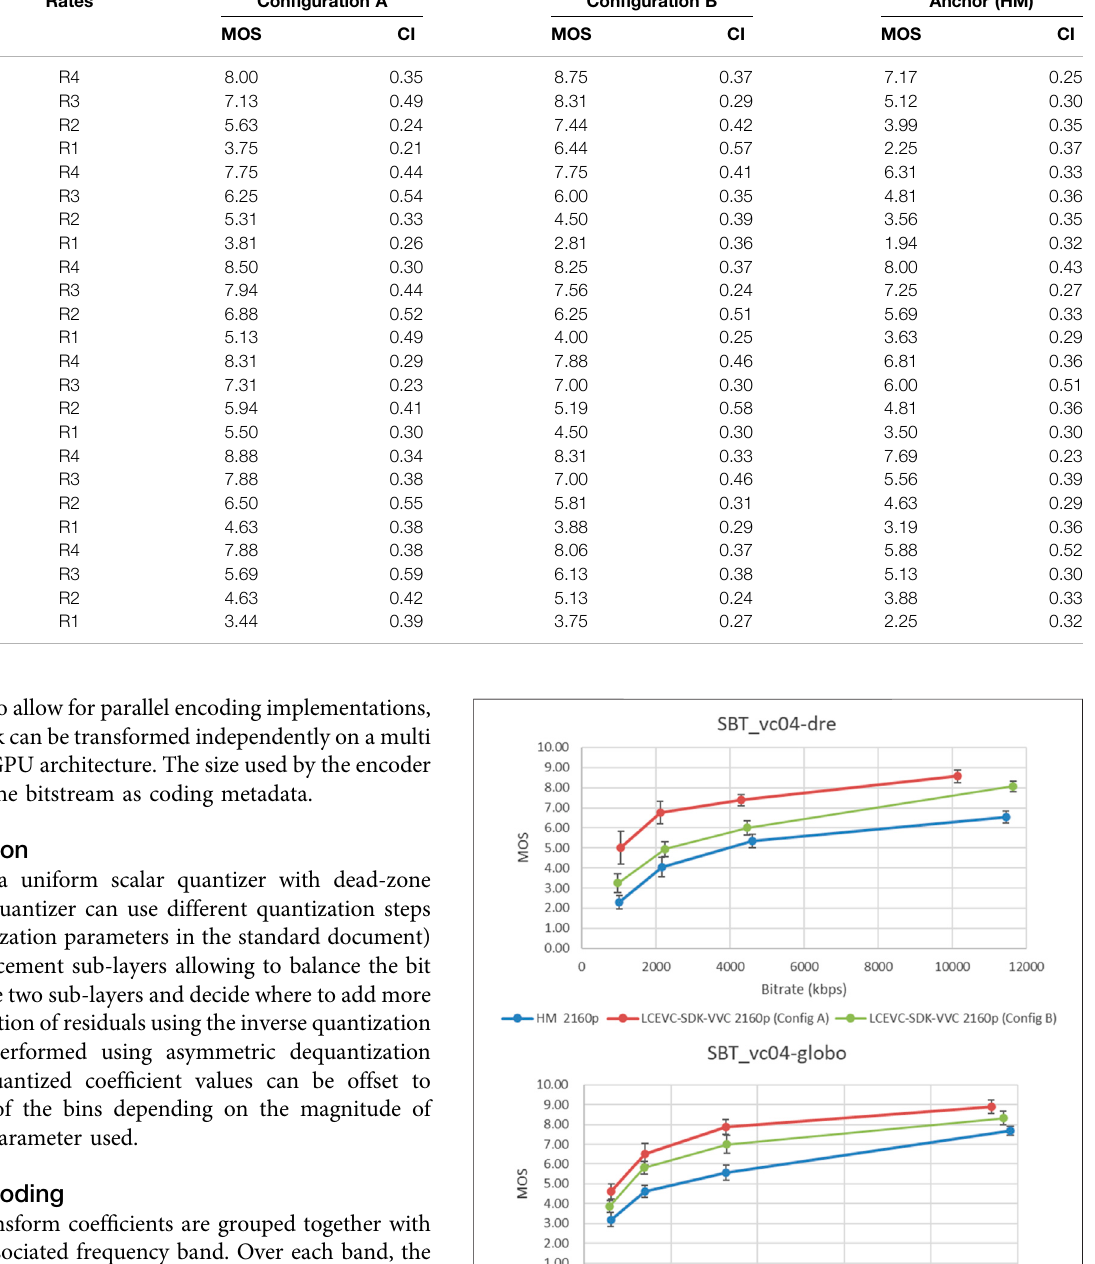
TABLE 4 | MOS scores and CI for HLG sequences. Sequence Rates Con fi guration A